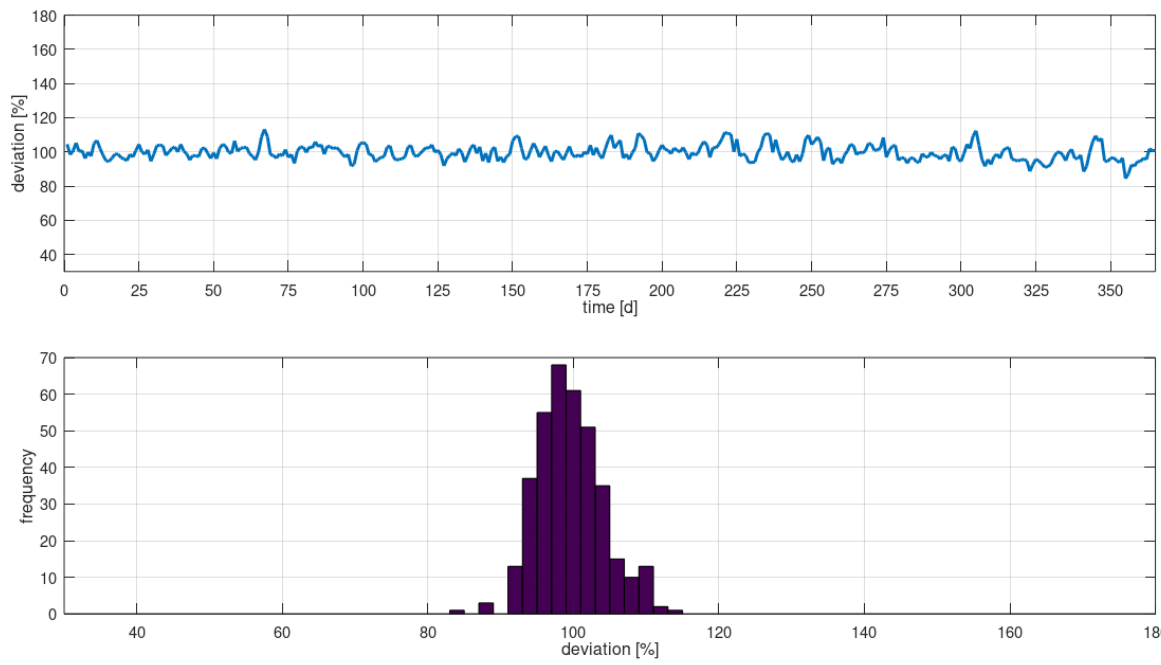
Figure 4. Validation of daily inventory levels.